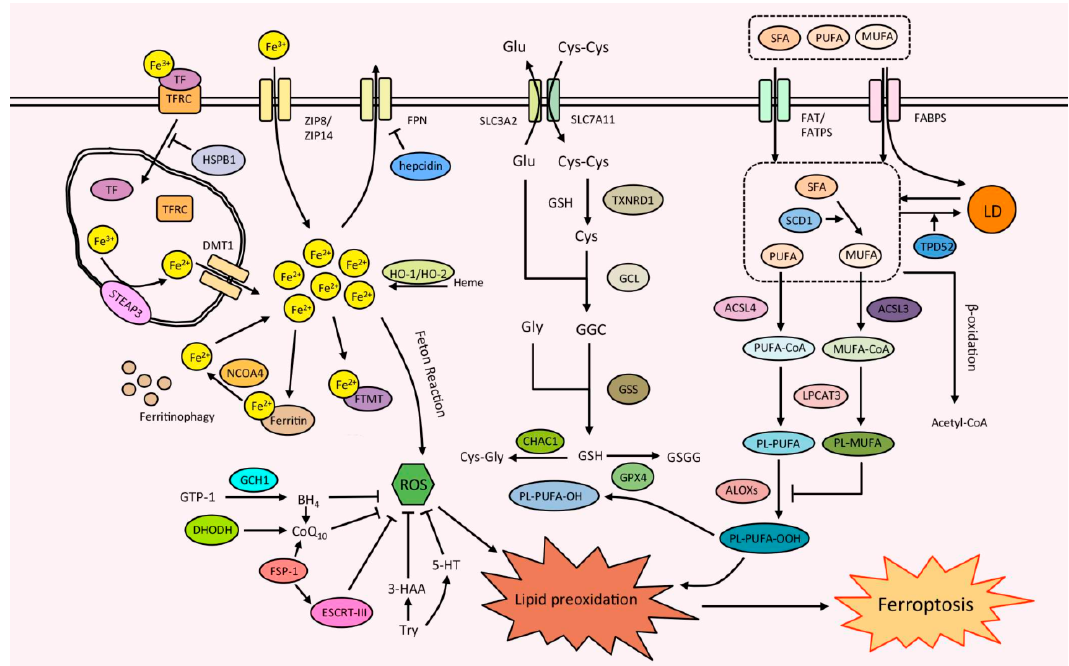
Figure 1. Ferroptosis is caused by the abnormal increased iron accumulation, lipid peroxidation, and dysregulation of antioxidant defense systems. There are complex regulations among iron metabolism, lipid metabolism, and the antioxidant defense system, and they cooperate with each other leading to lipid peroxidation and the occurrence of ferroptosis. Cys: cysteine; Cys-Cys: cystine; Cys-Gly: cysteinylglycine; Glu: glutamate; GGC: Gamma-Glu-Cys; GSSG: glutathione oxidized; LD: lipid droplet; PL: phospholipid; SFA: saturated fatty acid; and Try: